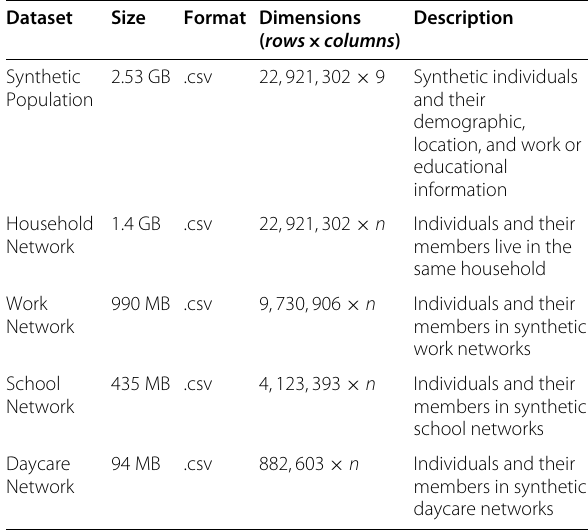
Table 2 Summary of the generated synthetic datasets ( n differs in the size depending on the network, n ∈ [ 0, 14]) Dataset Size Format Dimensions Description ( rows × columns ) Synthetic 2.53 GB .csv 22,921,302 × 9 Population